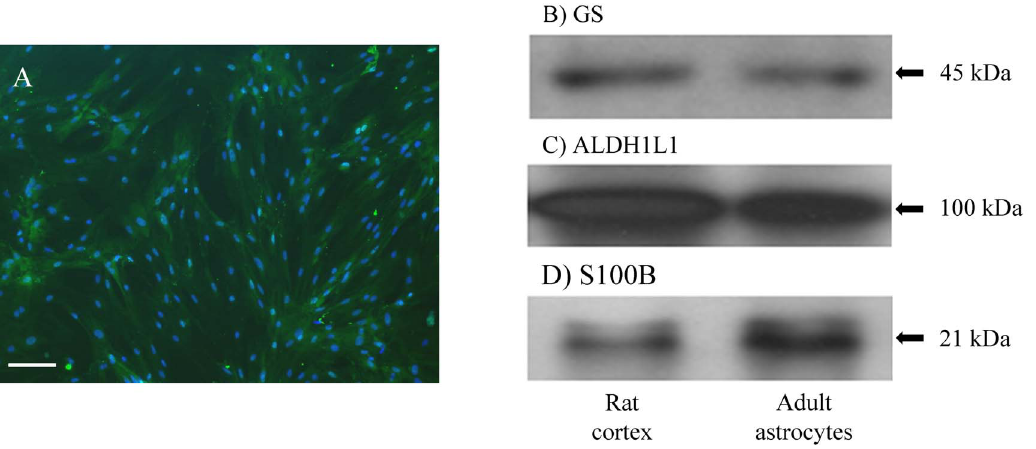
Figure 3. Adult astrocytes cultures express GS, ALDH1L1 and S100B proteins. ( A ) Immunocytochemistry of adult astrocyte cultures for GS with a merge for DAPI staining. Representative immunoblot band for ( B ) GS, ( C ) ALDH1L1 and ( D ) S100B. The left band represents rat cortex homogenate and the right band represents adult astrocytes. N=5 for all immunoblot experiments.